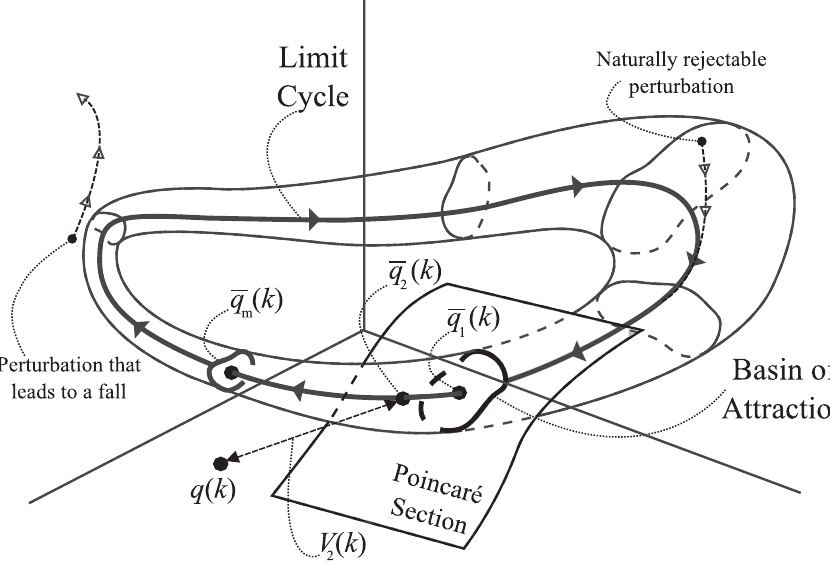
Fig. 2. 3-Dimensional abstraction of a limit cycle (solid line) together with its basin of attraction (enveloping surface). The Ensemble of Candidate Neighbors (ECN) is represented as slices in the limit cycle.